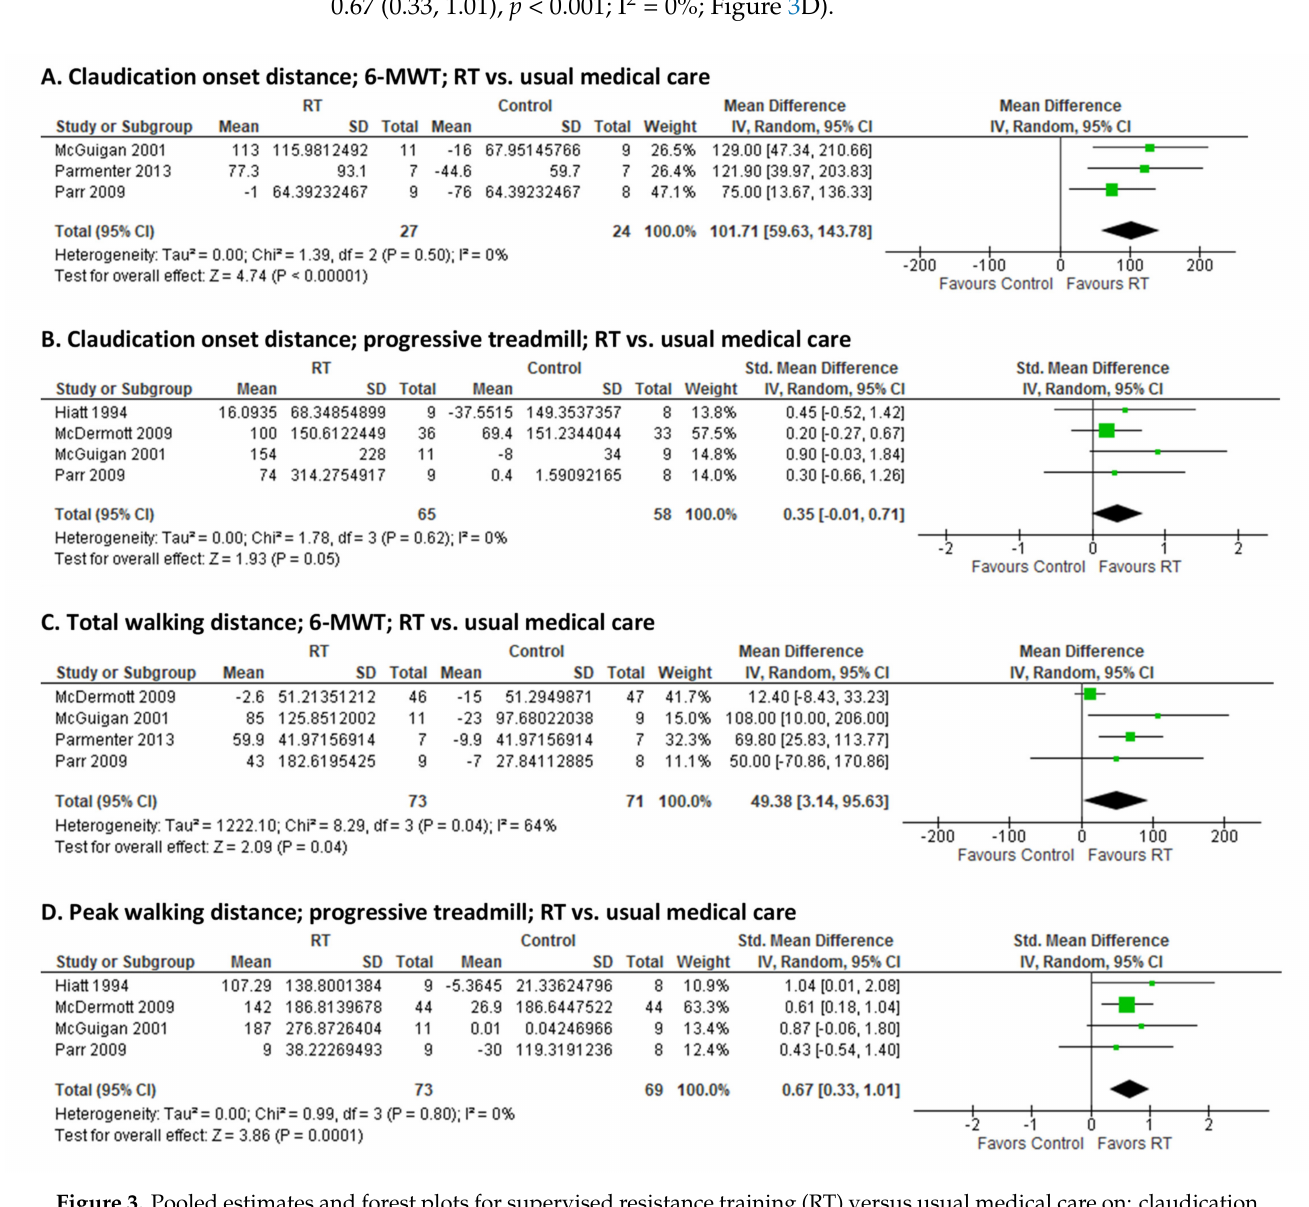
Figure 3. Pooled estimates and forest plots for supervised resistance training (RT) versus usual medical care on: claudication onset distance during a 6-min walk test (6-MWT) ( A ), progressive treadmill walking ( B ); total/peak walking distance during 6-MWT ( C ), progressive treadmill walking ( D